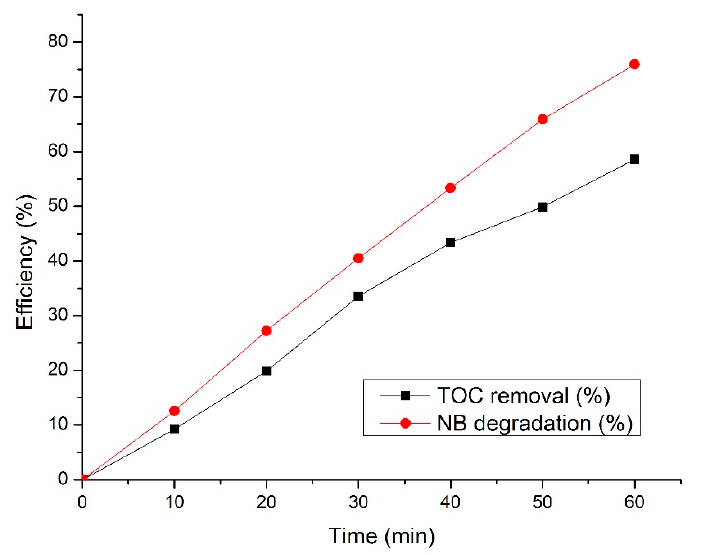
Figure 10. The total organic carbon (TOC) removal efficiency and NB degradation efficiency by the BDB system at an NB concentration of 20 mg/L, an oxygen flow rate of 3 L/min, and an applied voltage of 1.8 kV.